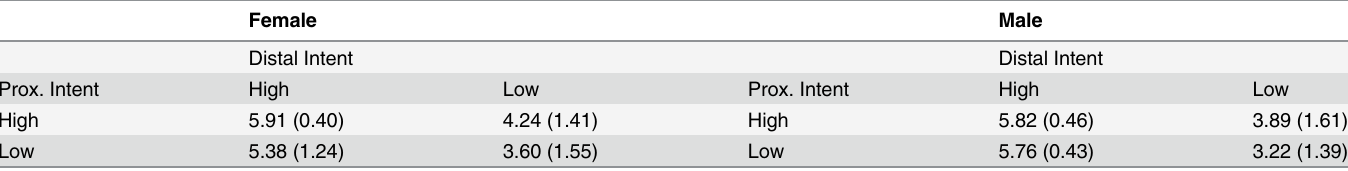
Table 4. Moral sanction of the actor. (Standard deviations in parentheses.) Female Male Distal Intent Prox.